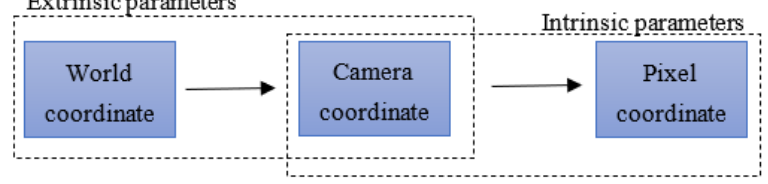
Figure 9. Intrinsic and extrinsic parameters.